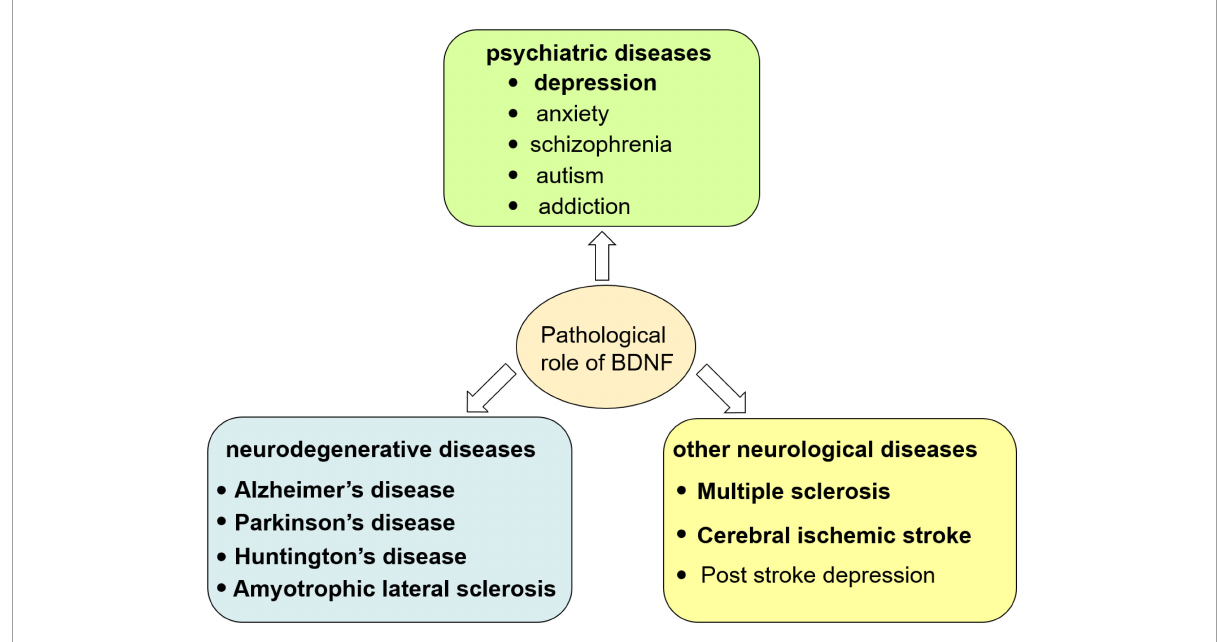
FIGURE2 Pathological role of BDNF in central nervous system. The dysfunction of BDNF signaling causes neurological disorders including psychiatric, neurodegenerative diseases and other neurological